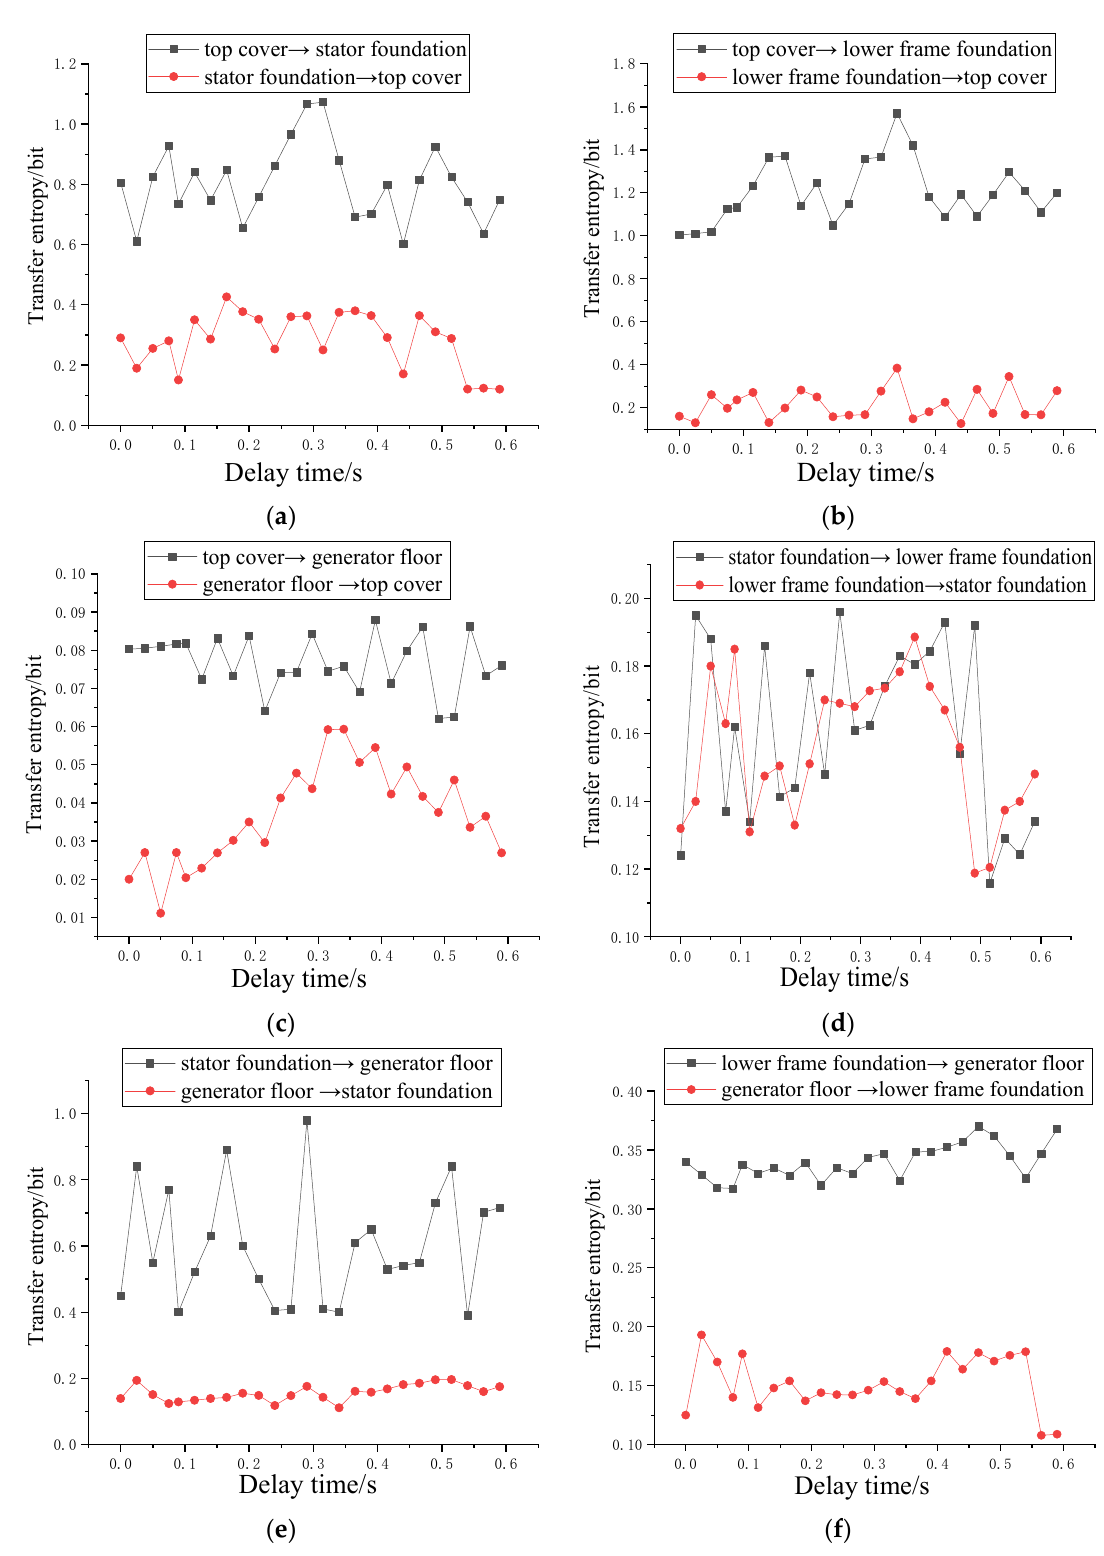
Figure 15. Transfer-entropy curve between measurement points of condition 2. ( a ) Transfer-entropy curve of top cover and stator foundation; ( b ) Transfer-entropy curve of top cover and lower frame foundation; ( c ) Transfer-entropy curve of top cover and generator floor; ( d ) Transfer-entropy curve of stator foundation and lower frame foundation; ( e ) Transfer-entropy curve of stator foundation and generator floor; ( f ) Transfer-entropy curve of lower frame foundation and generator floor.